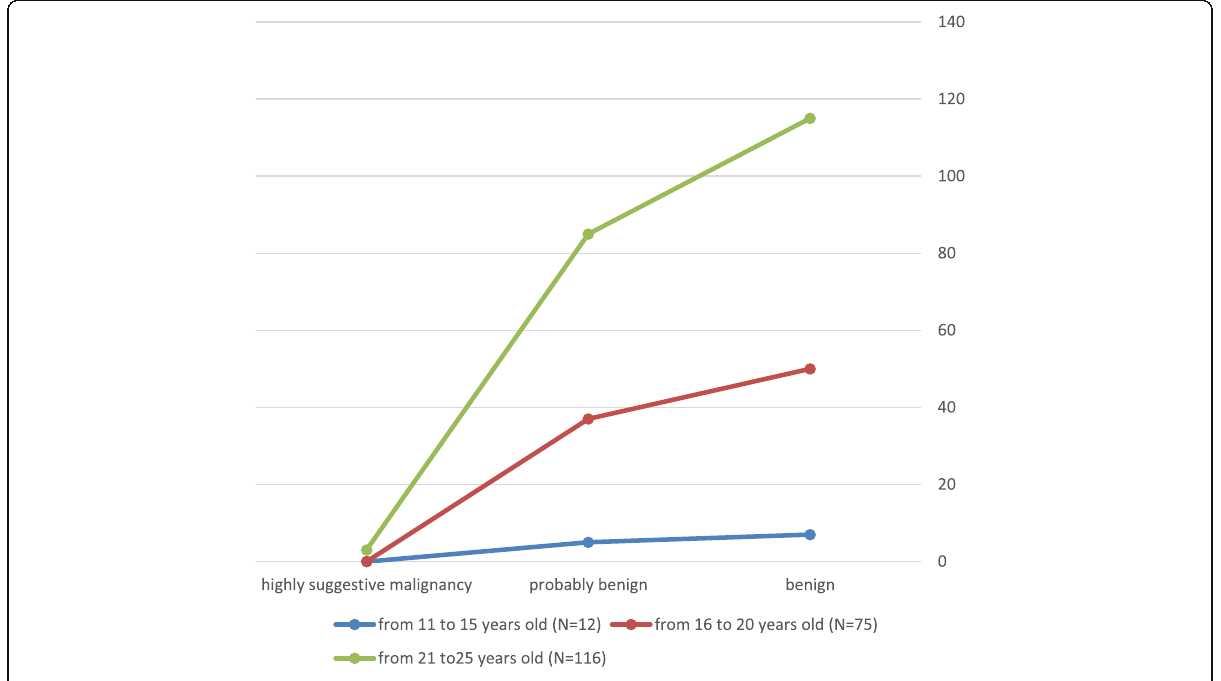
Fig. 3 The histopathology result according to age